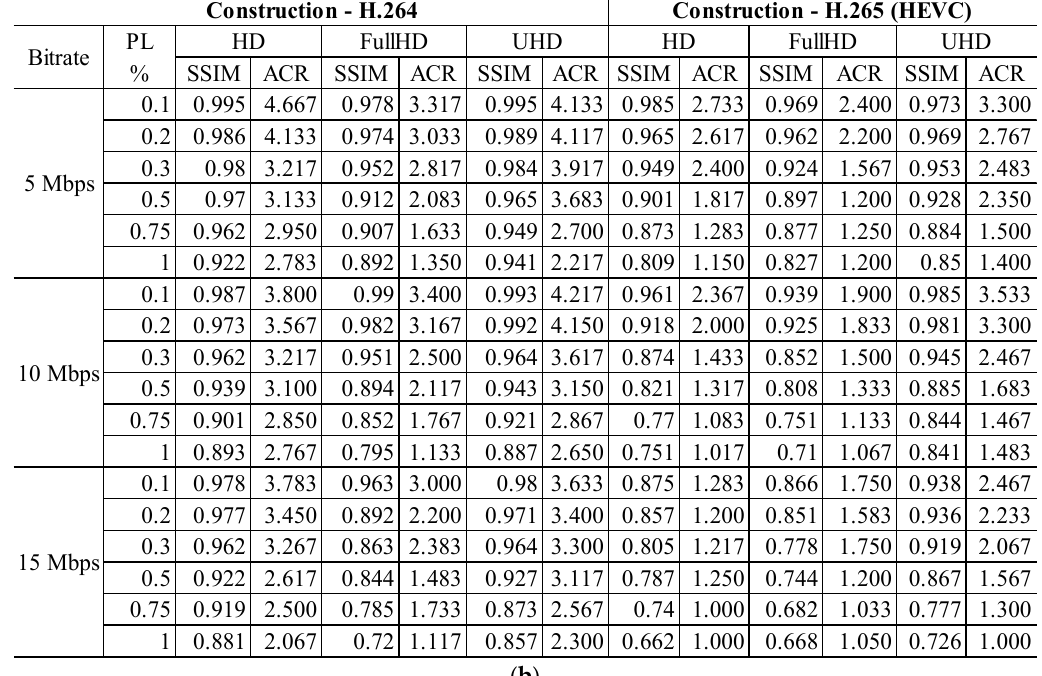
Figure 5. Subjective and objective metric results for the Campfire ( a ) and Construction ( b ) scenes.